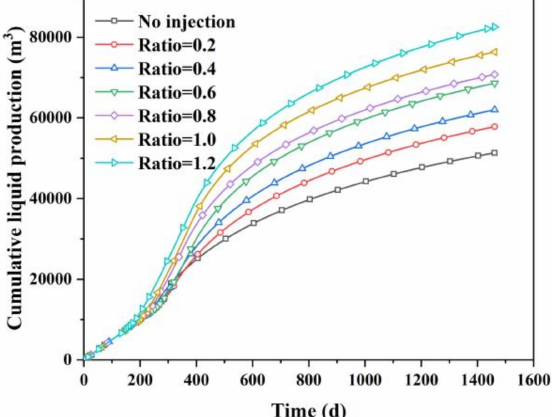
Figure 7. Cumulative liquid production of parent well.